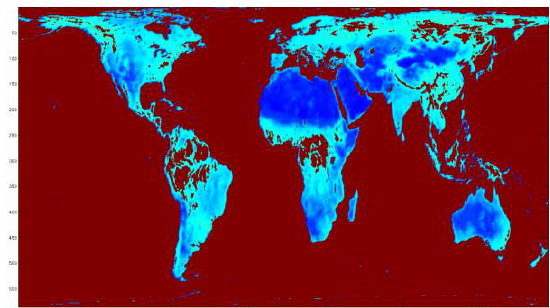
Figure 4. The soil moisture prediction using the SVR model.